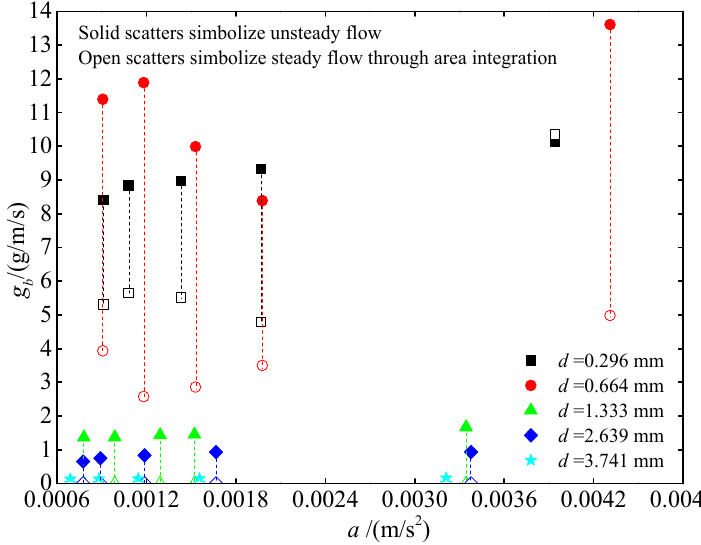
Figure 6. Comparison between steady flow through integration and unsteady flow transport rate under five uniform sand conditions.